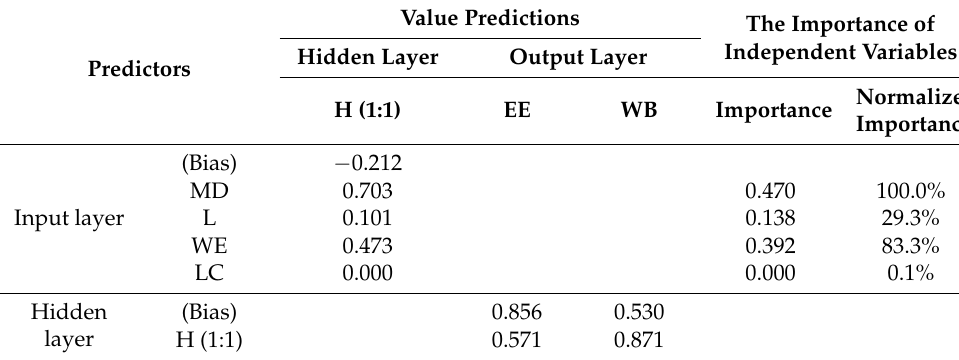
Table 4. Predictors of the multilayer perceptron model for identifying the influences of WB dimen- sions on the overall level of EE and WB. Value Predictions The Importance of Predictors H (1:1) EE WB Importance (Bias) 0.392 Input layer − 0.195